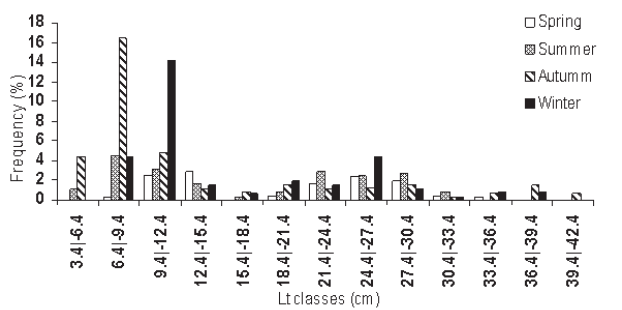
Fig. 4. Distribution of the relative frequencies of occurrence of specimens of Cichla kelberi in total length classes, by seasons of the year, at Lobo